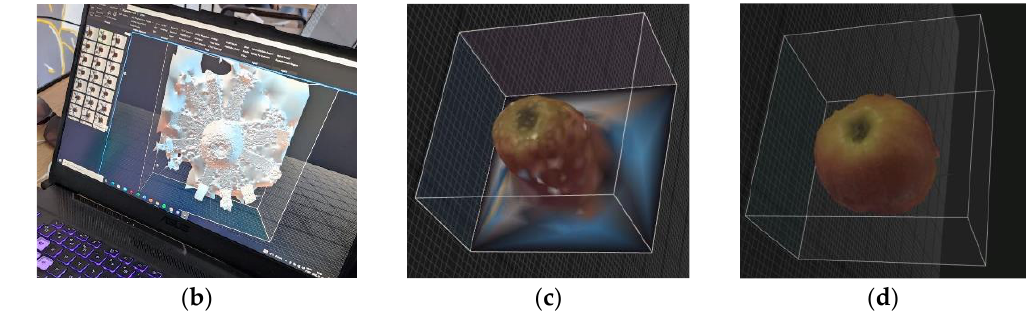
Figure 3. Second attempts outdoor photography with random environment of plush toy ( a ) Model; ( b ) Real toy.